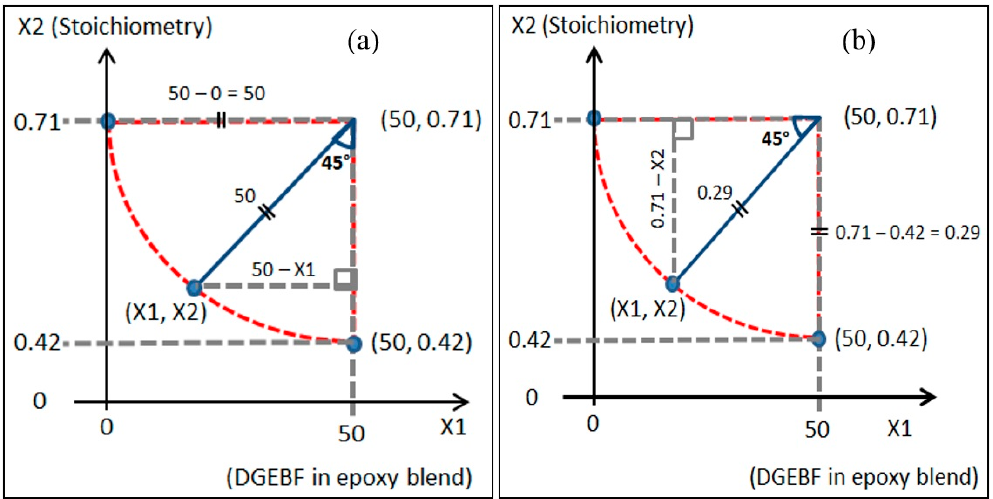
Figure 7. Cube point ( − 1, − 1) to determine the actual value for ( a ) X1, and ( b ) X2. From Figure 7a, X1: From Figure 7b, X2: